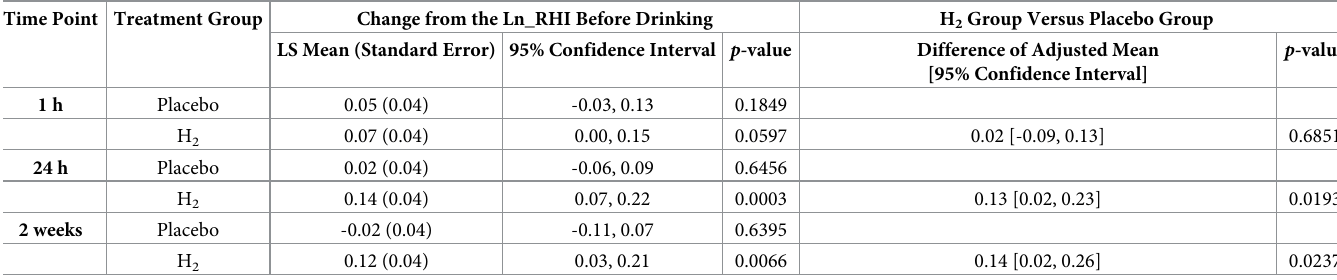
Table 2. Comparison between the two groups for all of the subjects.